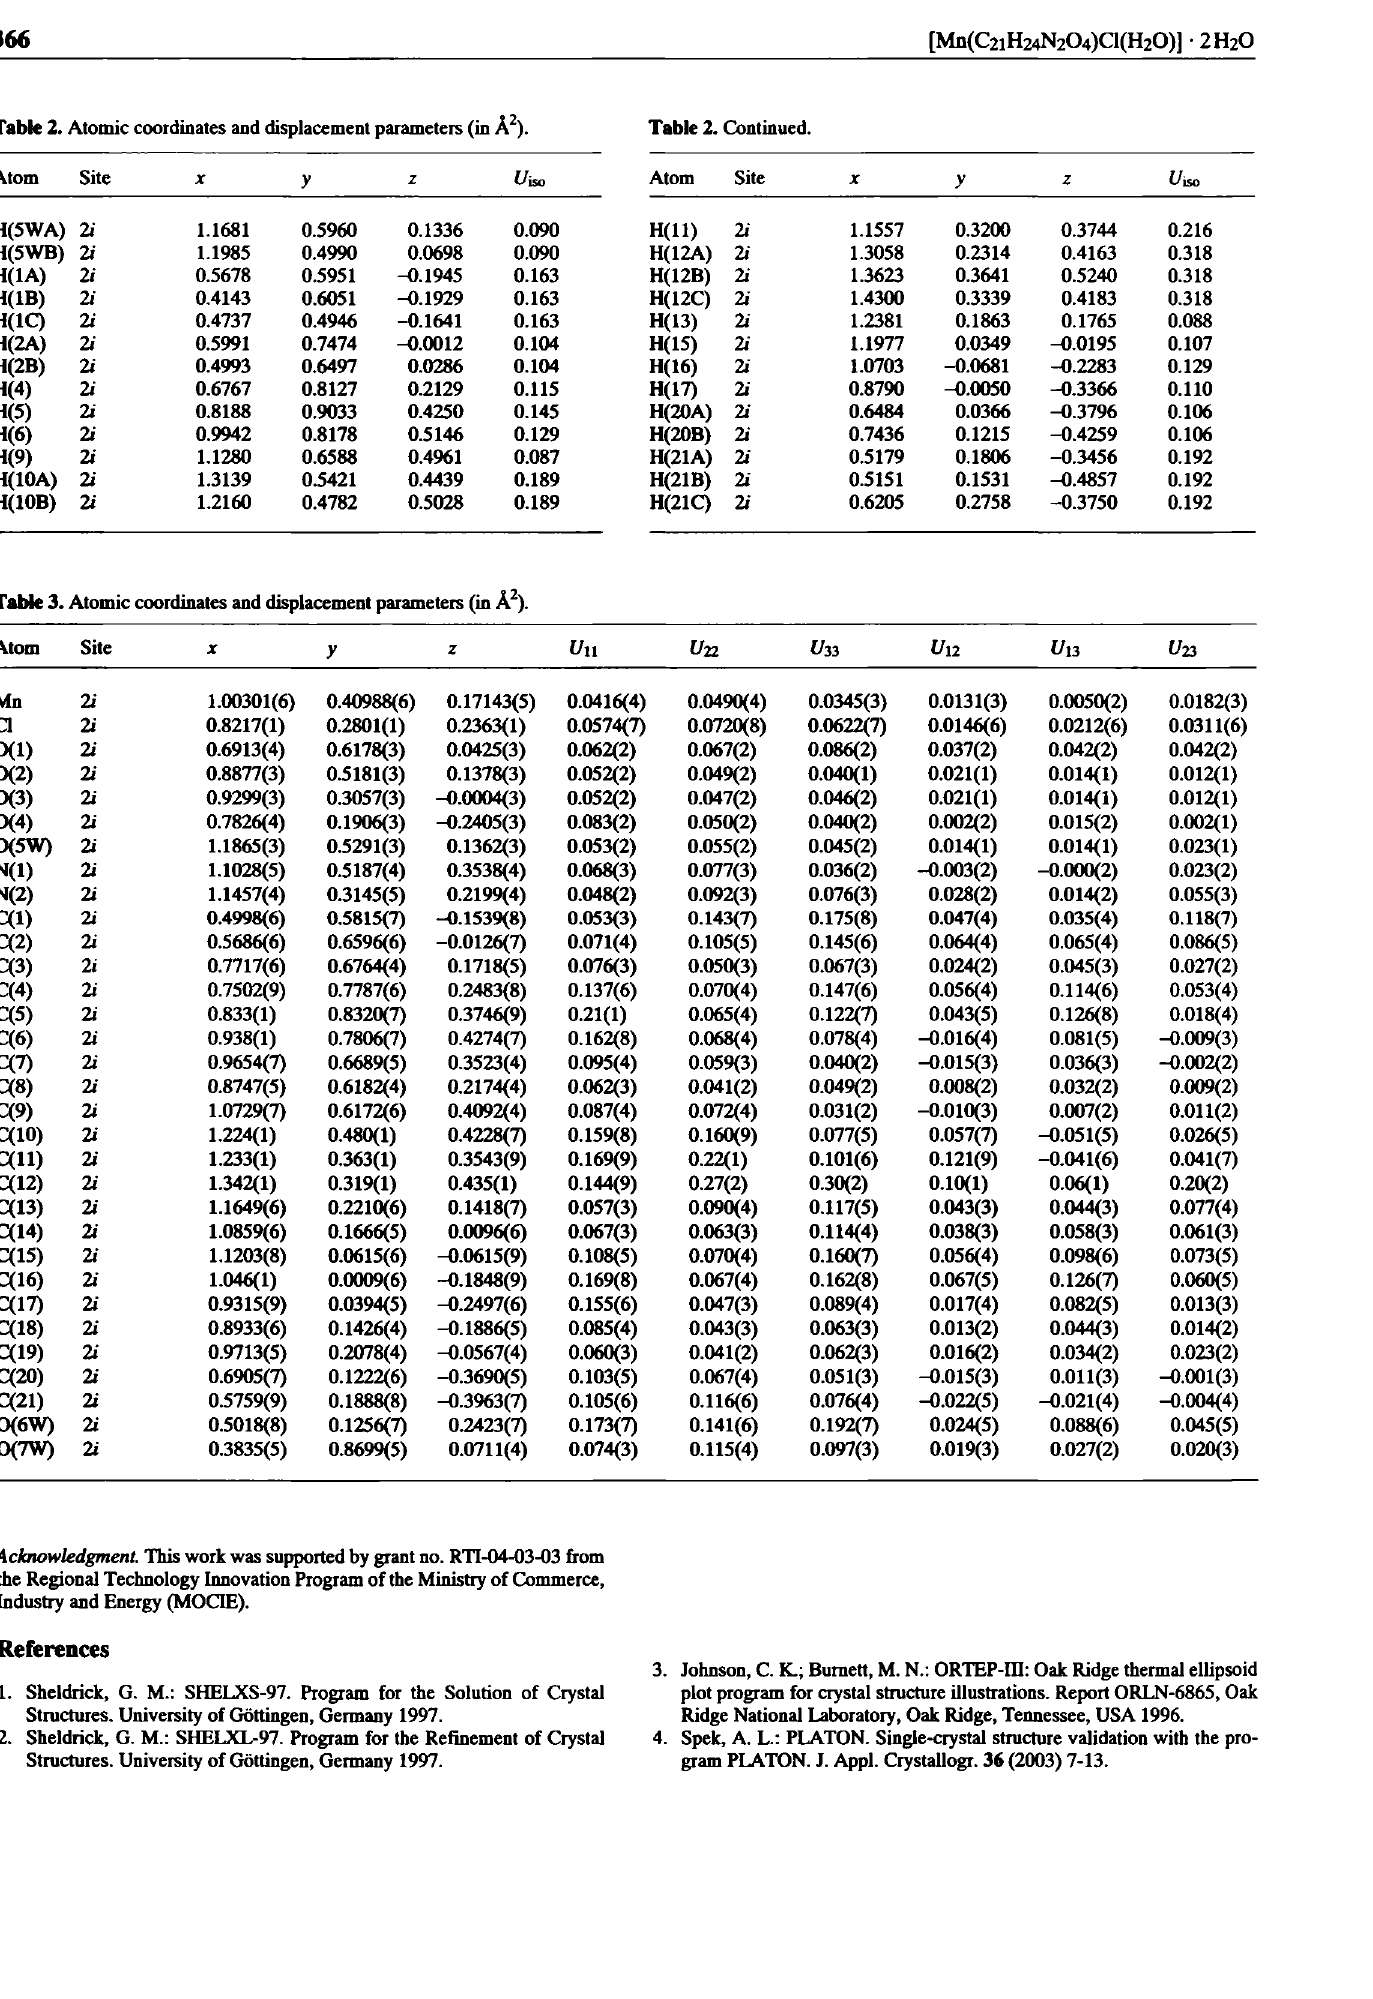
Table 2. Atomic coordinates and displacement parameters (in Ä 2 ).